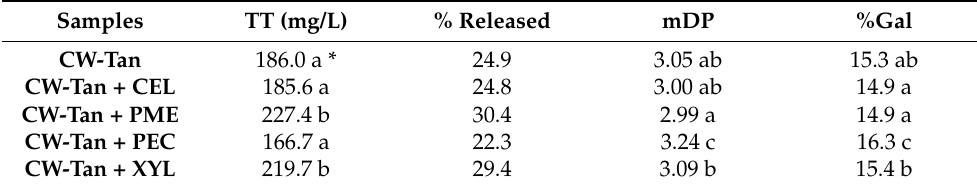
Table 2. Concentration and composition of released tannins into solution measured by phlorogluci- nolysis in the desorption